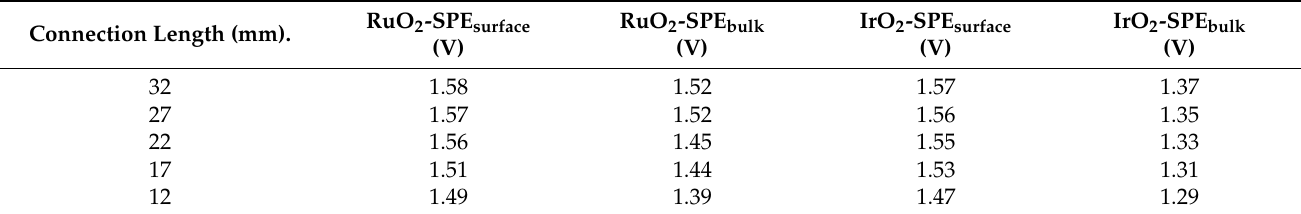
Figure 4. LSV for the different bulk-modified (10%) SPEs (SPE bulk ) with different connection lengths towards the HER (Pt/C (A) and MoS 2 (B) ) alongside LSVs for the bulk-modified (10%) SPEs with different connection lengths towards the OER (IrO 2 (C) and RuO 2 (D) ). LSVs were recorded in 0.5 M H 2 SO 4 using a three-electrode set-up consisting of an SPE working electrode, a Pt wire counter electrode and a Ag|AgCl reference electrode. Table 2. Summary of the onset potentials for the RuO 2 and IrO 2 catalysts, both as surface-modified and bulk-modified, on SPEs of different connection lengths. Measured in 0.5 M H 2 SO 4 with potentials reported vs. the reversible hydrogen electrode (RHE).